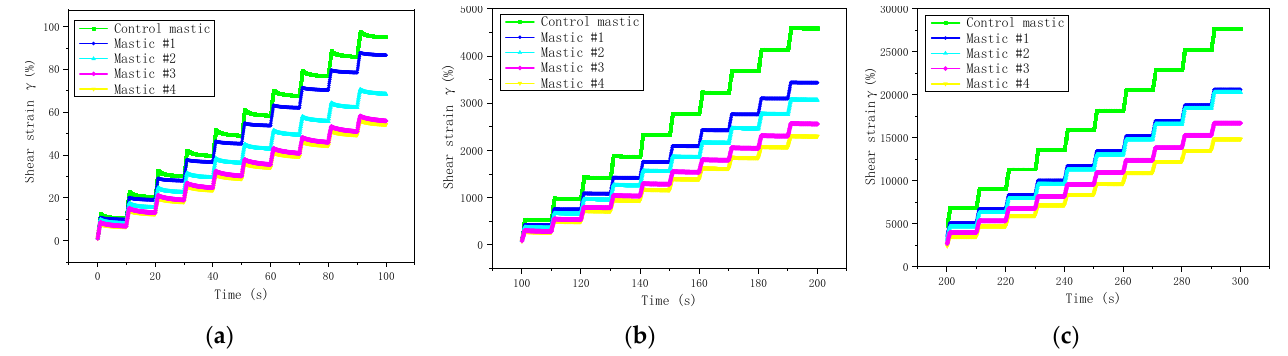
Figure 9. Shear strain variations with time. ( a ) 0.1 kPa; ( b ) 3.2 kPa; ( c ) 12.8 kPa. Due to the same filler-to-asphalt ratio, the shear strain of all the asphalt mastics showed very similar variations with time. However, LMF and HMF had different impacts Figure 10. Non-recovery creep compliances. on the increasing rate of shear strain. According to Figure 9, the non-recovery creep compliance (J nr ) and the creep recovery rate (R) were used to evaluate the rutting resistance of the tested mastics; Figure 10 and Figure 11 show their values, respectively.